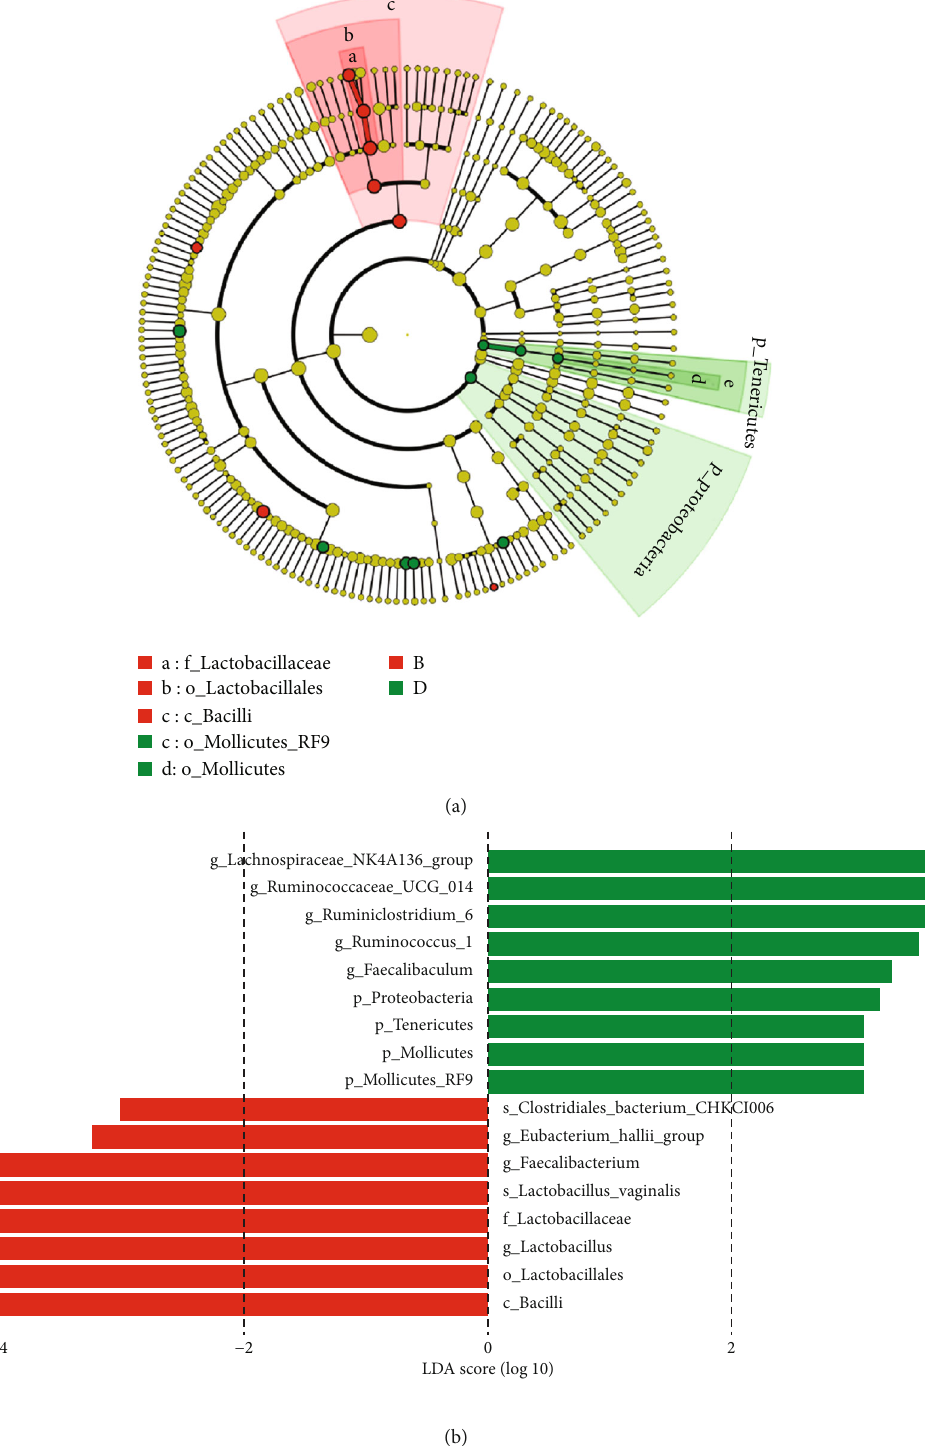
Figure 5: LEfSe identi fi ed the most di ff erentially abundant taxons between the medium-dose treatment group and the disease group. (a) Taxonomic cladogram obtained from LEfSe analysis of 16S sequences. (red) Tax enriched in IBS-D rats, (green) tax enriched in treatment group. The brightness of each dot is proportional to its e ff ect size. (b) Signi fi cant di ff erences in LDA scores ( P < 0 : 05 ) were produced among classes (Kruskal – Wallis test) and between subclasses (Wilcoxon ’ s test). Di ff erential taxa were determined based on a LDA threshold score of > 3 and a statistical signi fi cance level of 0.05 (p: phylum; c: class; o: order; f: family; g: